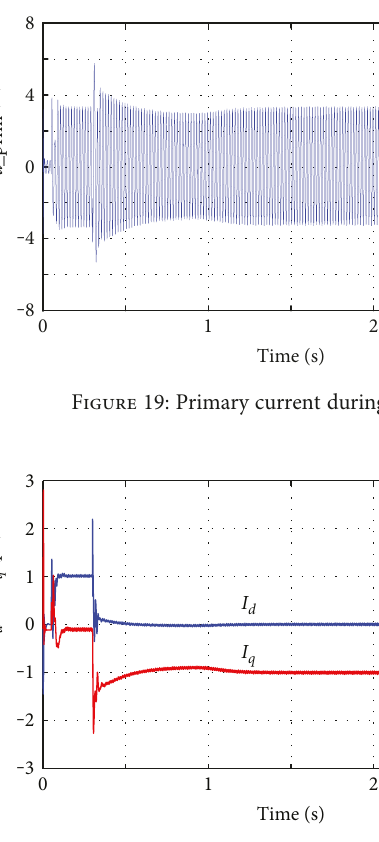
Figure 20: Currents I